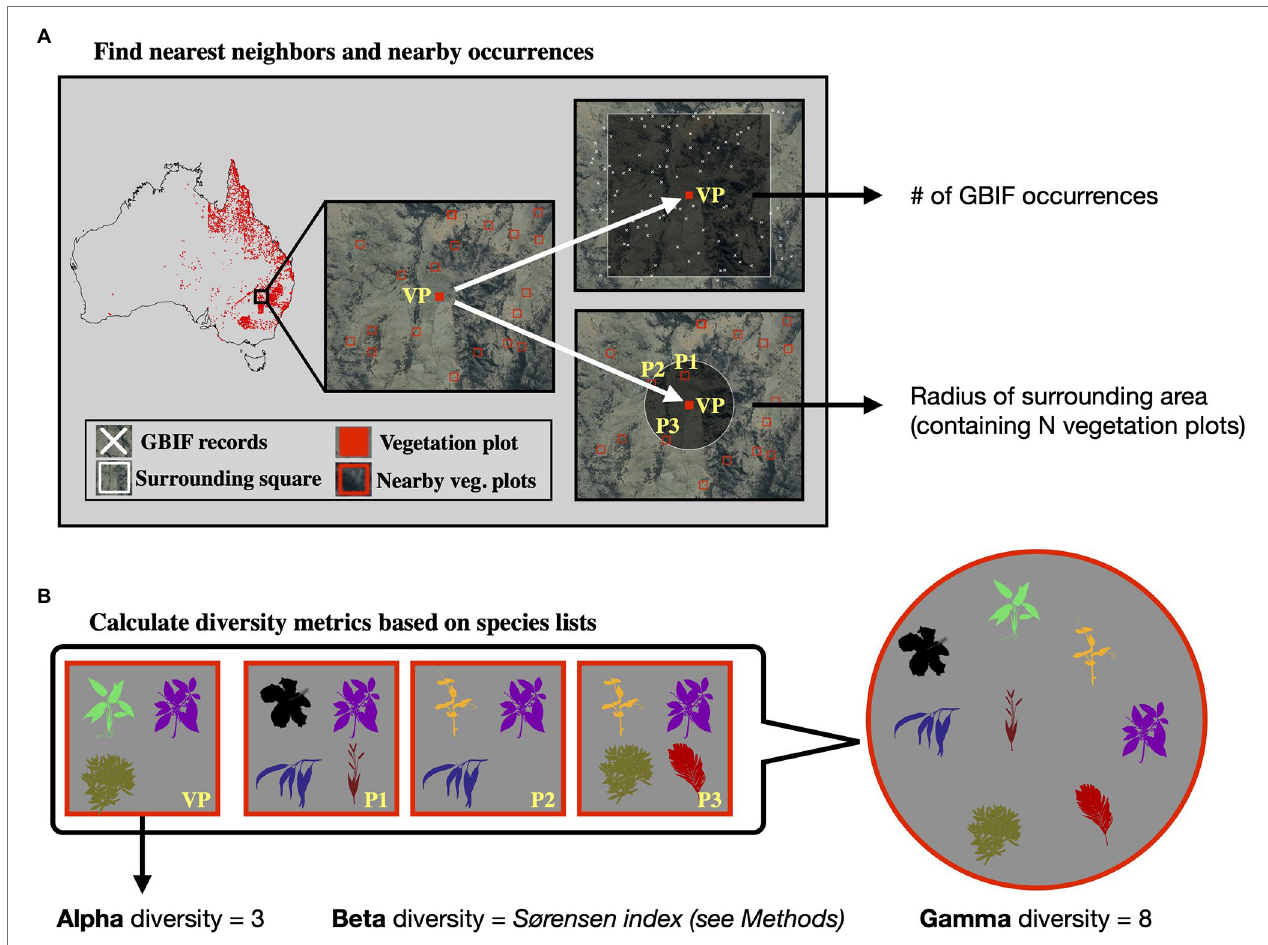
FIGURE 2 | Calculation of diversity measures from vegetation plot data. For a given vegetation plot (VP, solid red square, panel A ) we identified the N nearest neighboring vegetation plots in space ( N = 3 in this example, represented by plots P1–P3). We exported the radius of the smallest circle encompassing all N neighbors as a feature for model training. Additionally, we exported the number of GBIF occurrences within a square of 10 × 10 km size around the given vegetation plot, as a measure of sampling effort in the general area. Having identified the nearest neighbors (P1–P3), we compared the species lists of these vegetation plots with the focal vegetation plot (VP, panel B ). Alpha diversity represents the number of species found in the focal vegetation plot (VP), while gamma diversity represents the total diversity consisting of all species identified among the focal and neighboring vegetation plots. Beta diversity was calculated using the multiple- site Sørensen dissimilarity index (see section “Materials and Methods”), based on the differences in species composition found among the selected vegetation